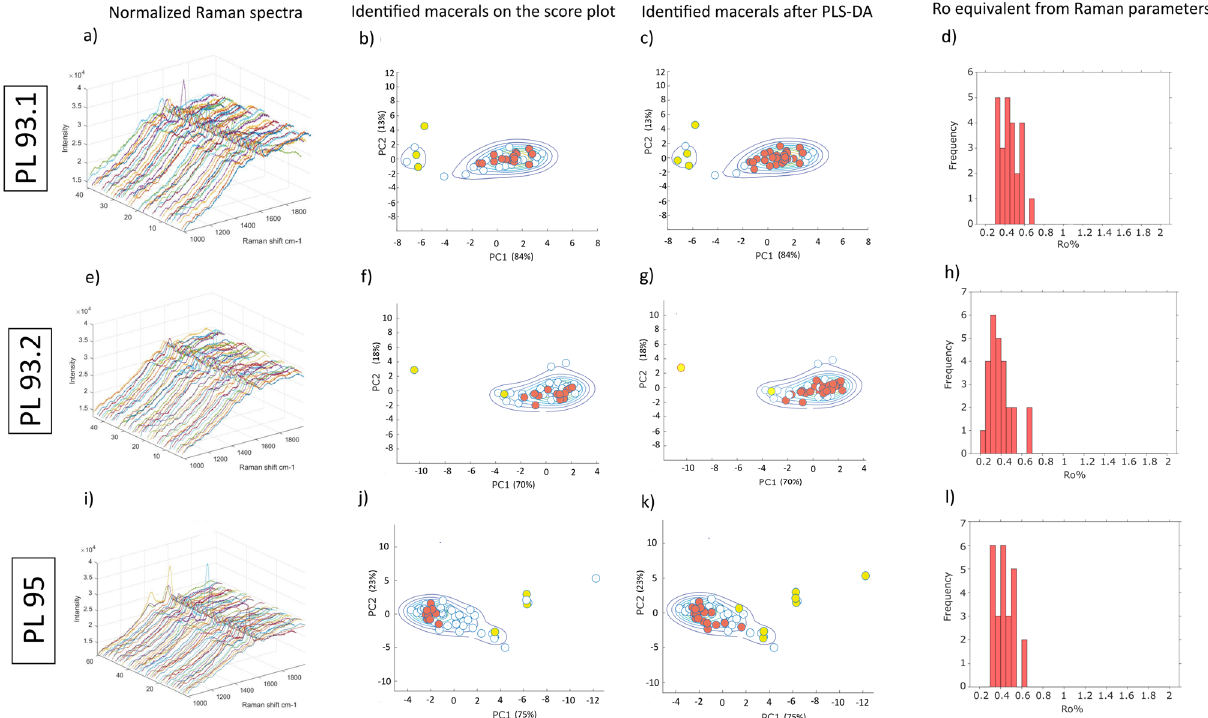
Figure 6. Results for samples PL 93.1, PL 93.2 and PL 95. Figures ( a , e , i ) show the raw spectra in a 3D view. Figures ( b , f , j ) the score plots distribution: red dots indicated optically recognized vitrinite while yellow dots optically recognized inertinite. Figures ( c , g , k ) show optically recognized and identified after PLS-DA vitrinites (red dots) and inertinites (yellow dots); number in brackets refers to explained variance by each principal component. Figures ( d , h , l ) histograms of R o % equivalent values from Raman parameters calculated on vitrinite recognized by means of PLS-DA.